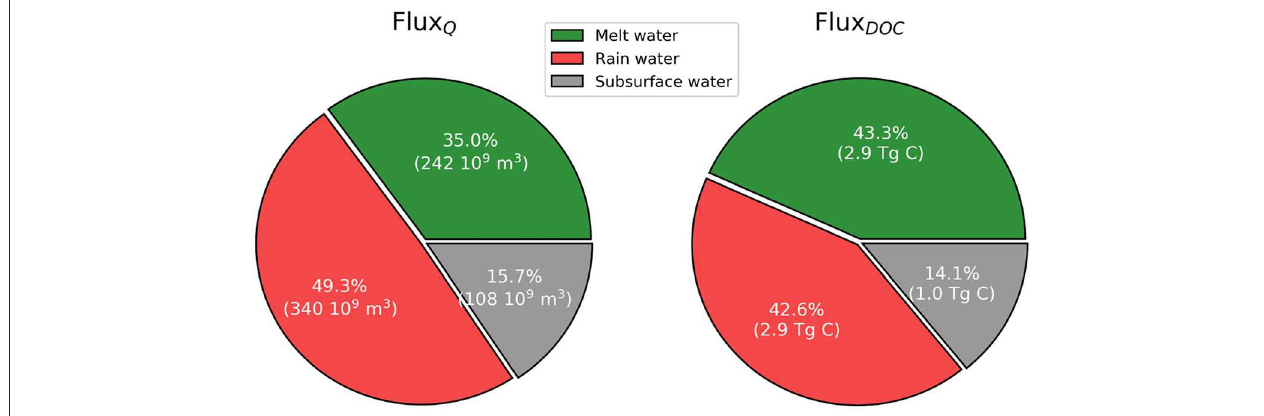
FIGURE 9 | Percentage and absolute fractions of discharge flux (Flux Q ) and DOC flux (Flux DOC ) for each endmember water source.